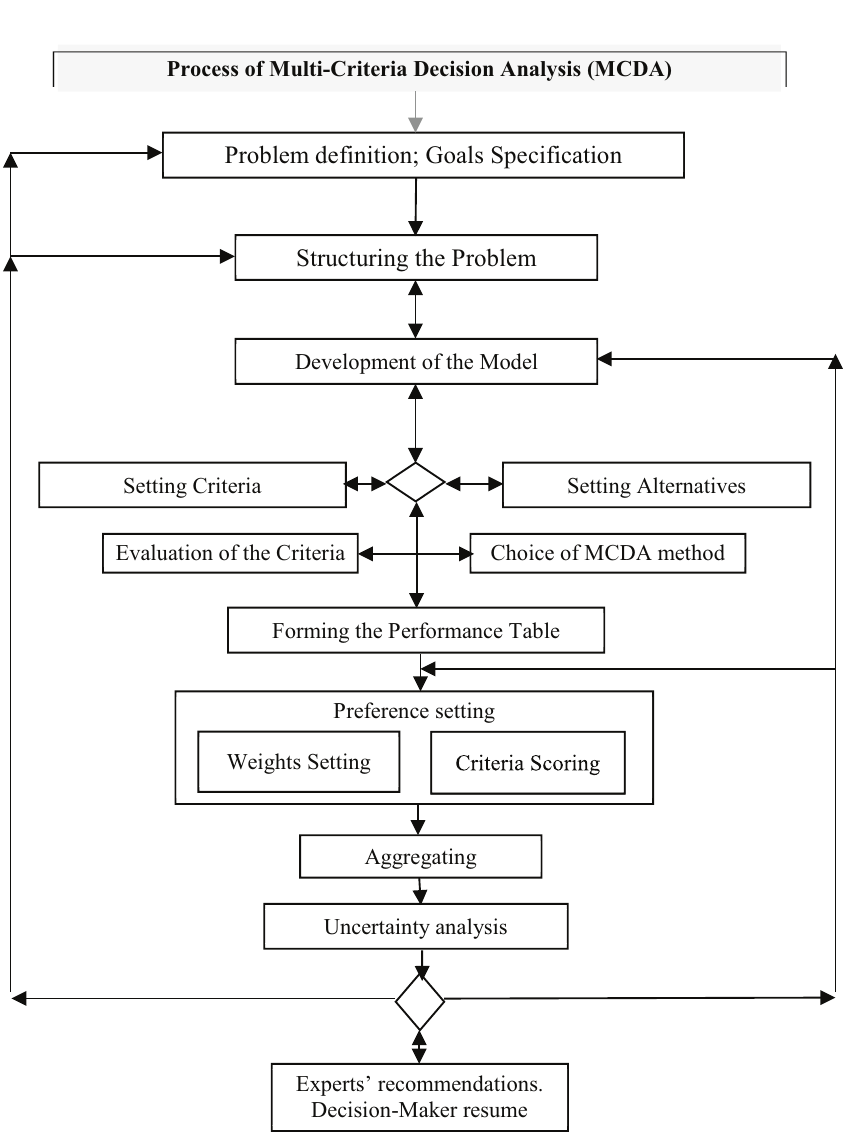
Fig.1. Aggregated scheme of the MCDA